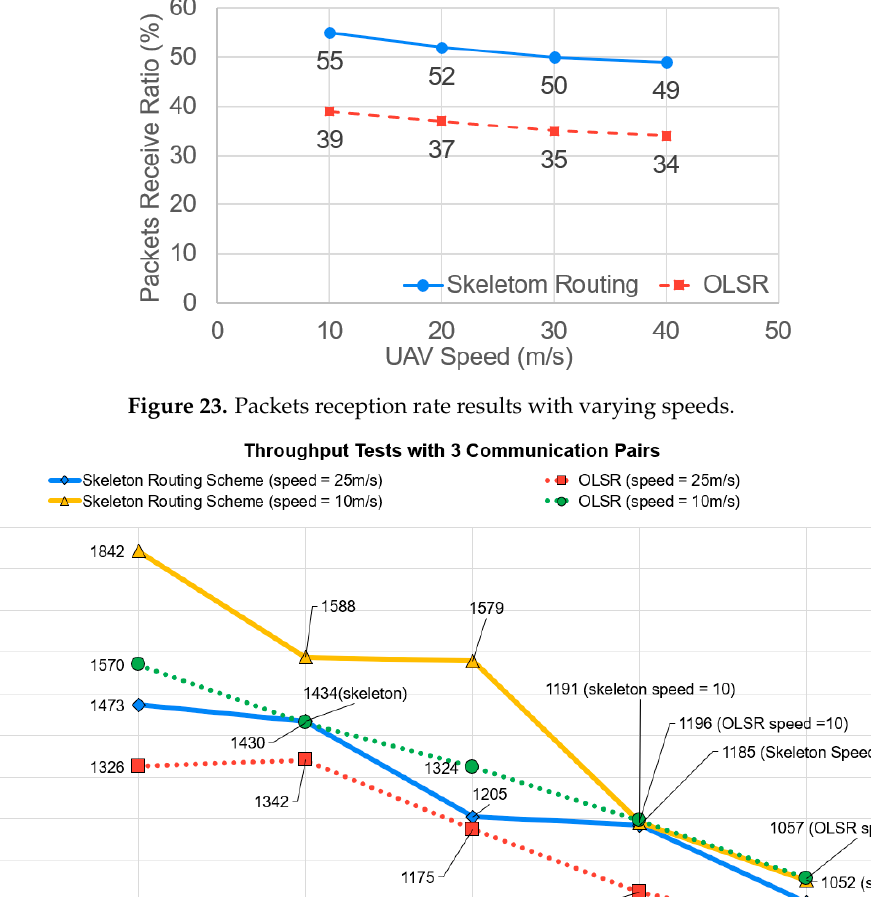
Figure 24. Throughput with different network sizes and node speeds.